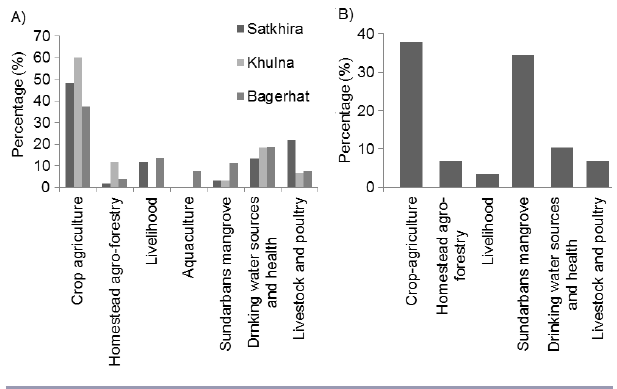
Fig. 4 . Coastal systems most affected by salinity increase in southwest region.